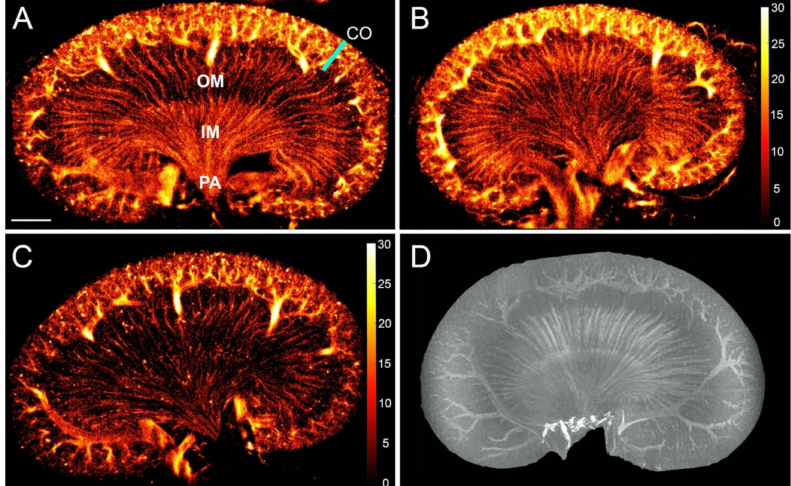
Figure 2. ( A – C ) Super-resolution images (log-scaled, i.e., color bar shows the value of intensity after logarithmic compression, ranging from 0~30 dB, and intensity corresponds to the number of microbubbles) of the healthy rat renal microvasculature. ( A ) There is a clear distinction between the dense cortical (CO) microvascular network and the vasa recta of the outer medulla (OM) and inner medulla (IM), leading down to the papilla (PA). Even though the scans were performed under the same conditions, the images show how the number of microbubbles varied between the rats, indicated by the higher intensity on image ( B ) (average of 117 detected microbubbles / frame) compared with image ( C ) (average of 70 detected microbubbles / frame). ( D ) Ex vivo magnetic resonance T1 contrast-enhanced image of another rat kidney for comparison. The kidneys measure approximately 2 cm in craniocaudal length and 1 cm in the medial-lateral direction. Scale bar: 2